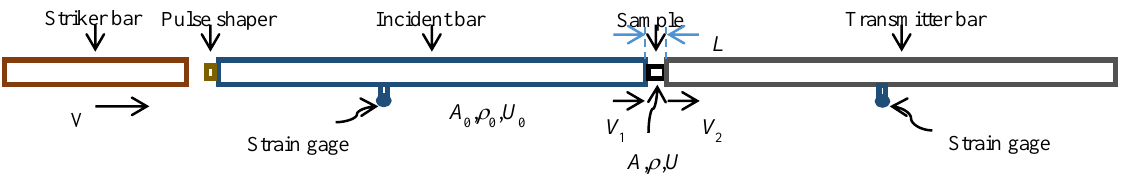
Figure 3. The in situ compression test equipment. Table 1. The parameters of resin material provided by manufacturers.